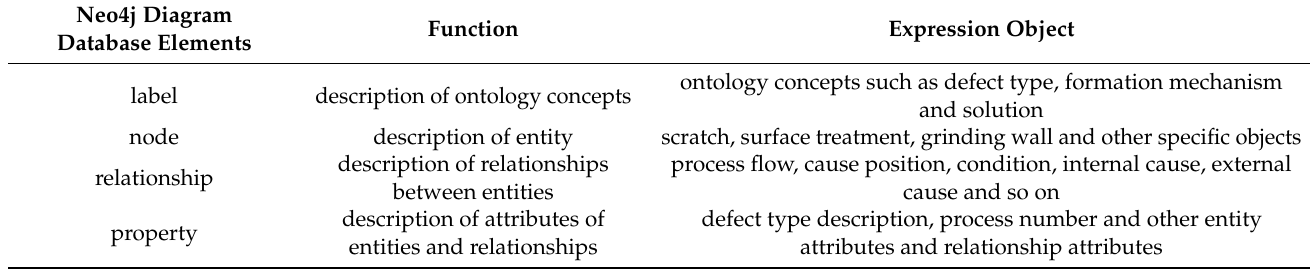
Table 10. Neo4j diagram database element description.